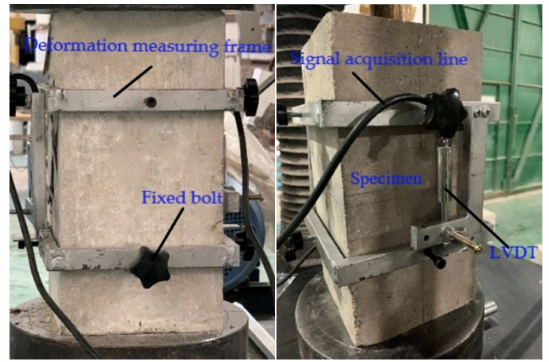
Figure 5. The device of uniaxial compression test.